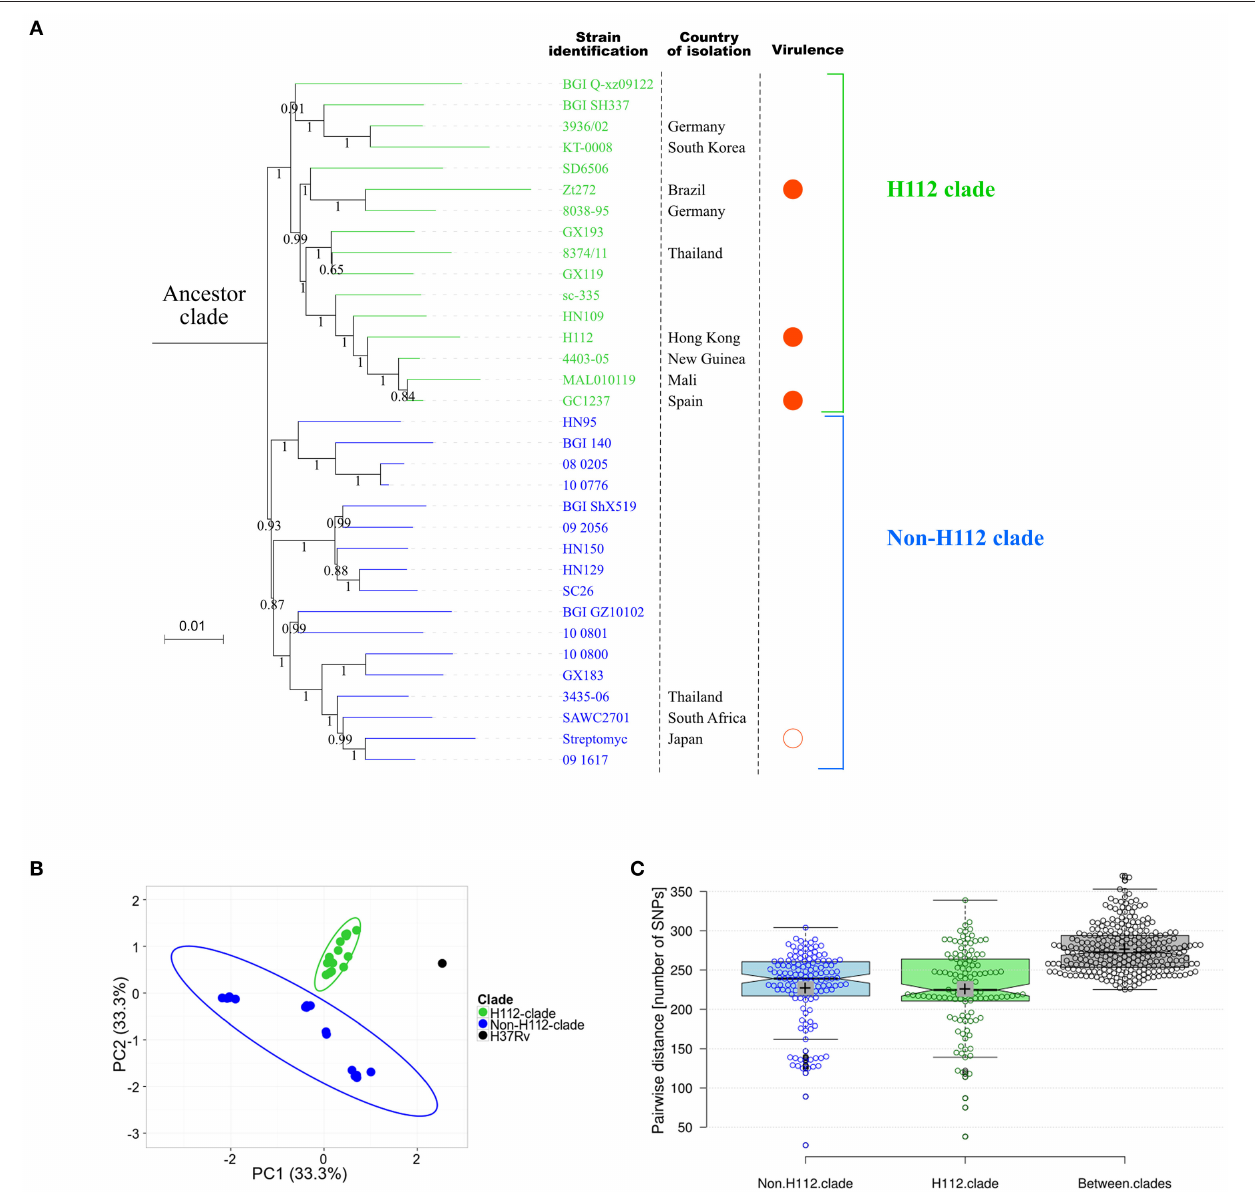
FIGURE 4 | Extensive genomic comparisons between H112 and previously published genome sequences. (A) Maximum-likelihood phylogeny based on previously published genomes related to H112. Branch labels indicate bootstrap values on ratio scale 0–1. Scale bar indicates nucleotide substitutions per site. Strain identifications, country of isolation, and virulence is indicated adjacent to the corresponding tips. Country of isolation is mainland China unless otherwise indicated. For virulence column, filled circles represent high virulence and empty circle represent low virulence. No circle is drawn in case of unknown virulence. (B) Results of principal component analysis showing clear distinction between identified clades. Each dot represent a sequence used in the analysis. An ellipse is drawn to show distinction between H112 and non-H112 clade. (C) A Tukey boxplot showing comparison of pair-wise SNP differences within H112-clade, non-H112-clade and between them. Box covers 25 and 75th percentile of the data. Center line indicates median and cross indicates mean. Each circle represents a pairwise comparison in bell-swarm representation { n = 136 (non-H112-clade), 120 (H112-clade), 272